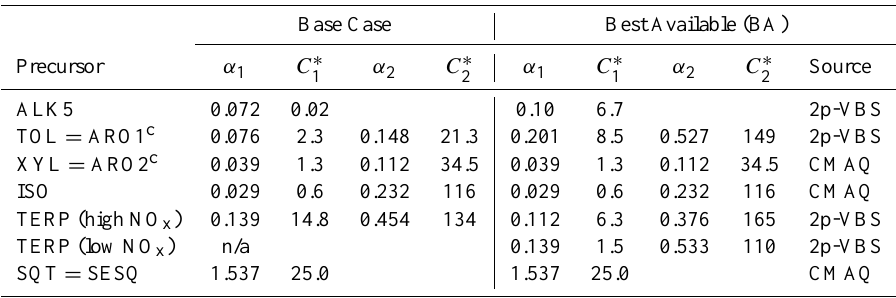
Table 3. Default parameters (base case) and best available parameters for biogenic high NO x (BA-highNO x ) and biogenic low NO x (BA- lowNO x ) used in CMAQv4.7.1 simulations a ; T = 298K and densities b matched to reported densities for base case (Carlton et al., 2010). Data references not provided in this work can be found in Carlton et al. (2010) for 2p parameters and in Tsimpidi et al. (2010) for VBS parameters.